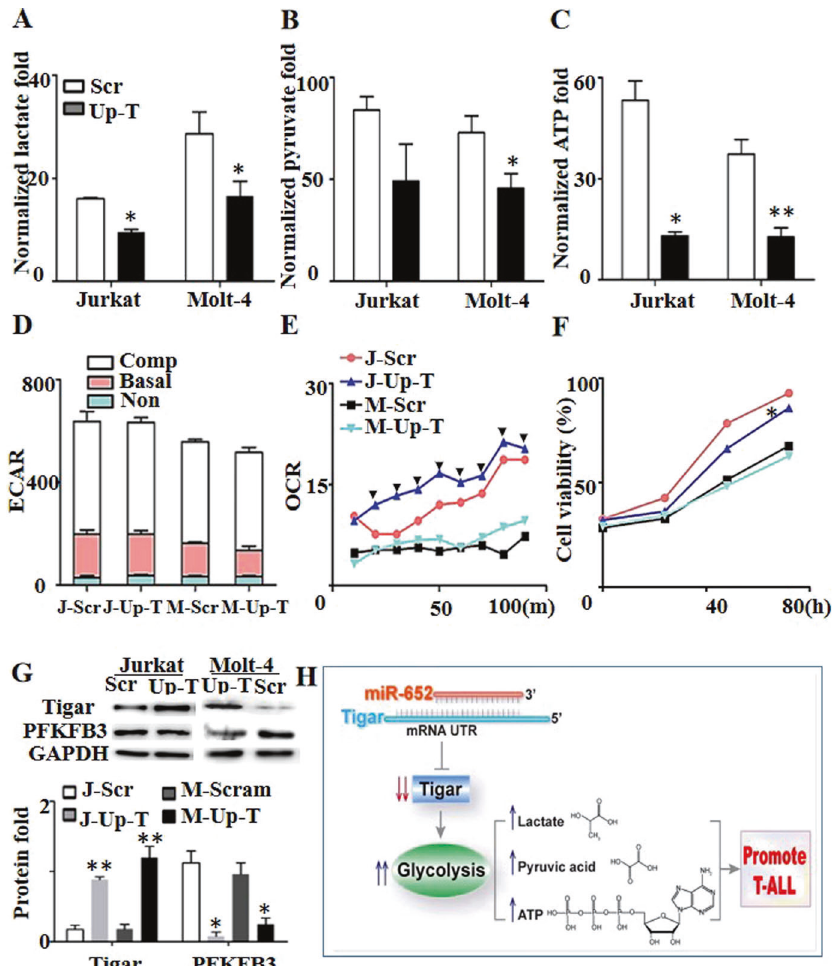
Fig. 4 The role of over-expression of Tigar in T-ALL cells. Gas Chromatography-Tandem Mass detected ( A ) the lactate content, ( B ) pyruvate content, and the value was normalized to internal control. ( C ) Effect of over-expressed Tigar on the production of ATP. ( D ) Extracellular acidi fi cation rate (ECAR) and ( E ) Oxygen consumption rate (OCR) were detected by fl uorescence microplate analyzer. ECAR was divided into three parts: non-glycolytic ECAR, basal ECAR (glycolytic ECAR) and compensatory ECAR with the stimulation by oligo. ( F ) Role of over- expressed Tigar on growth by CCK-8 assay. ( G ) The expression of protein. Top, the representative image of Western Blot. Bottom, the statistics and normalized to control as 1.0. ( H ) Schematic diaphragm showing the miR-652-5p-mediated pathway. Scr control, Up-T over-expressed Tigar, ECAR extracellular acidi fi cation rate, OCR oxygen consumption rate, m minutes, h hours, J Jurkat cell lines, M Molt-4 cell lines. Basal, basal glycosis; Non, the ECAR from non-glycosis; Comp, compensatory glycosis from stimulation with oligo. p is compared to control and calculated by t student; * p < 0.05; ** p < 0.01., indicated the signi fi cance at certain time point, compared to control, p <